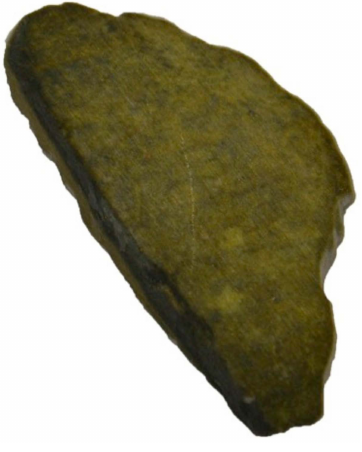
Figure 6. Colored